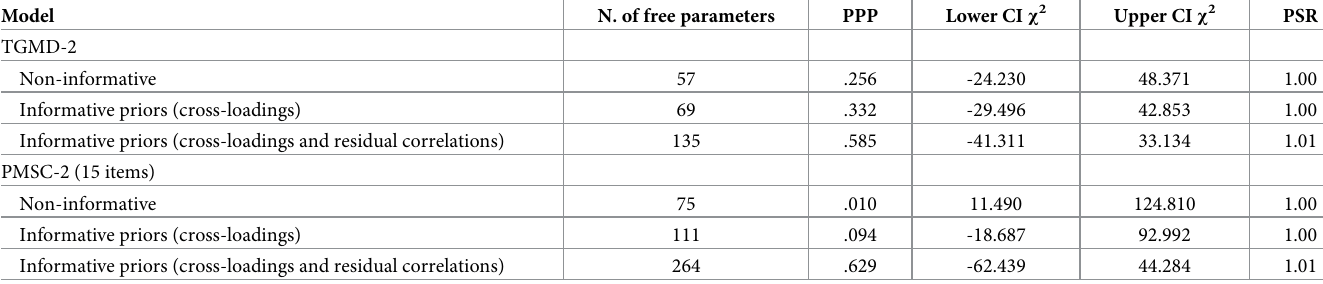
Table 1. BSEM fit and convergence ( n =